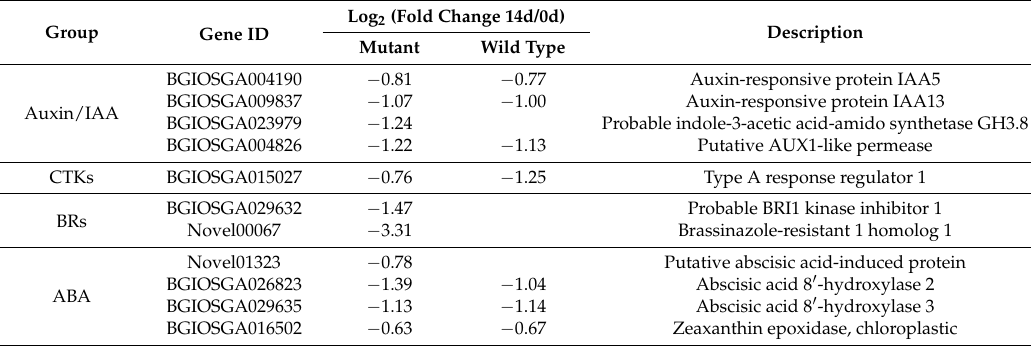
Table 6. Genotypic differences in expressions of DEGs encoding proteins associated with hormone signaling pathways between the initial and 14th day of the grain-filling stage (padj < 0.05).